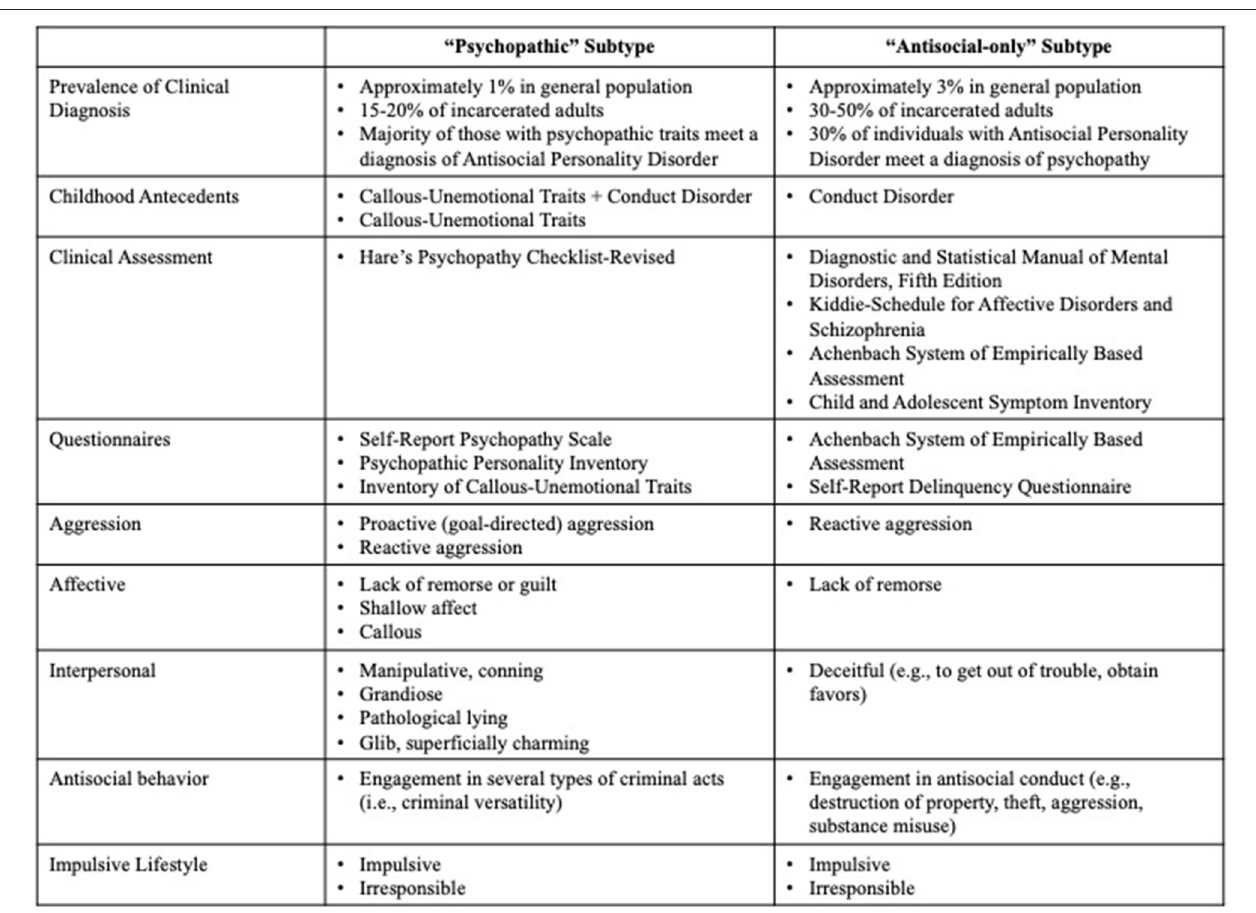
FIGURE 1 | Clinical assessment tools and phenotypes for “psychopathic” subtype vs “antisocial-only” subtype. Information represents common tools and tendencies across subtypes of antisocial individuals.